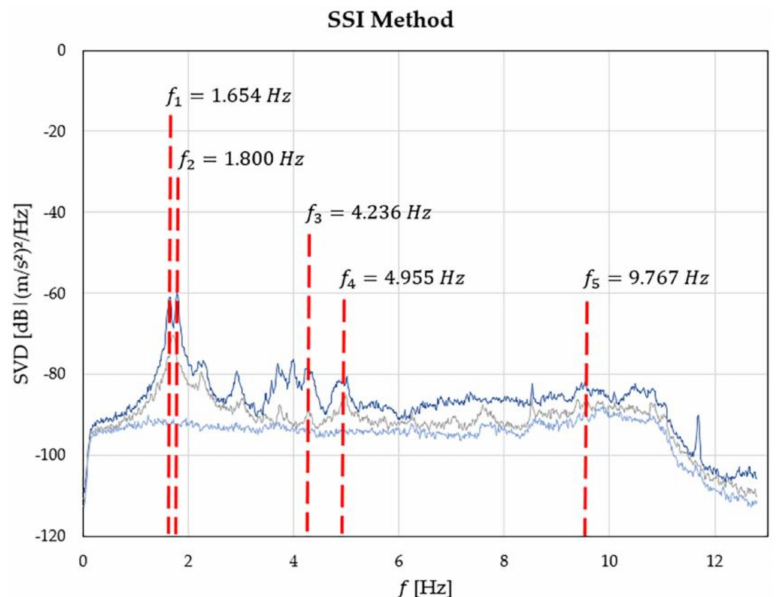
Figure 4. Frequency estimation graph.